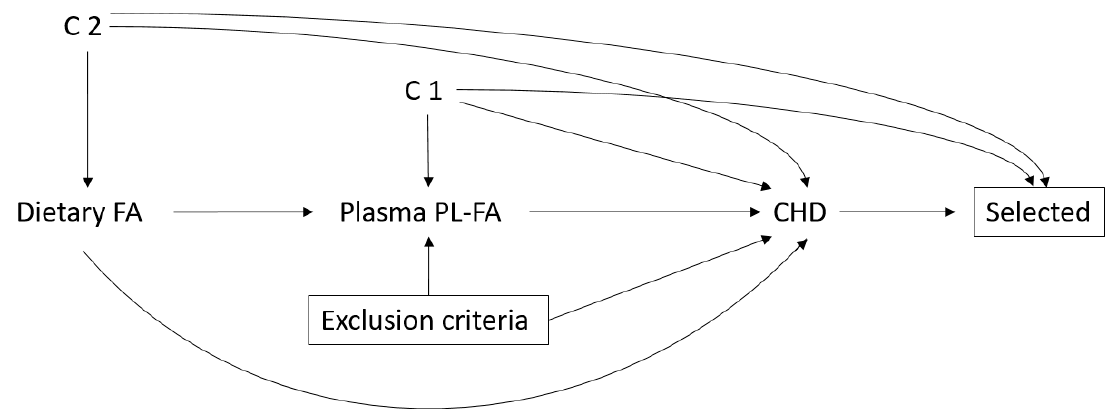
Figure A1. Hypothesized causal diagram for the matched case-control study. C1 includes age, race/ethnicity, life style factor (BMI, physical activity, and smoking), CHD risk factors (family history of myocardial infarction/diabetes/stroke, medication use, postmenopausal hormone use, self-reported hypertension/diabetes/hypercholesterolemia, and hysterectomy status), and dietary factors (alcohol, percent calories from protein/carbohydrates, and total energy intake). C2 additionally included region, education, and income. A box around a node represents conditioning on that node. Abbreviations: